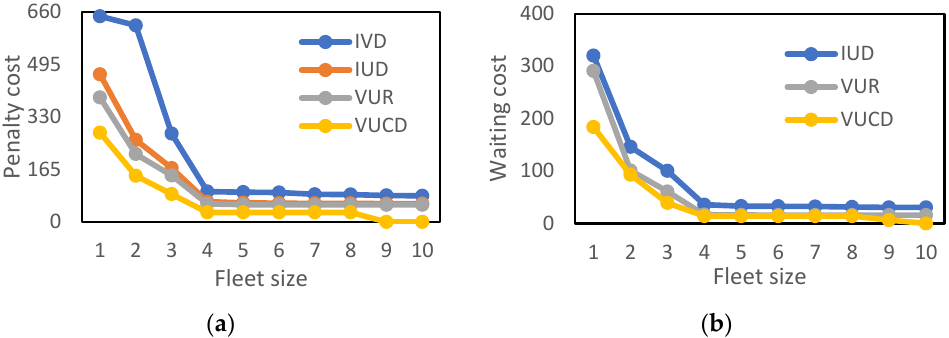
Figure 9. Penalty cost and waiting cost of different models. ( a ) Penalty cost of different models; ( b ) Waiting cost of different models.